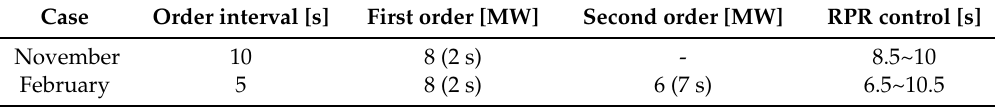
Table 3. Reference signal change for case studies. Reactive power reserve: RPR.